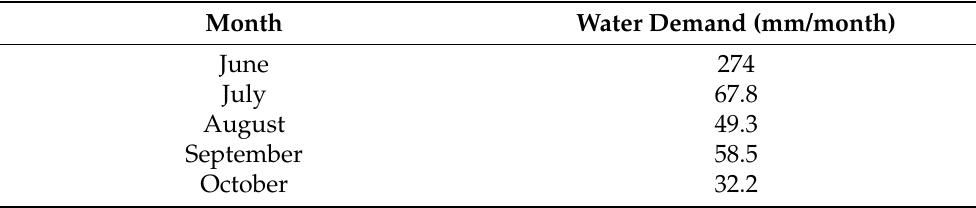
Table 1. Water demand for the rice grown in each month.